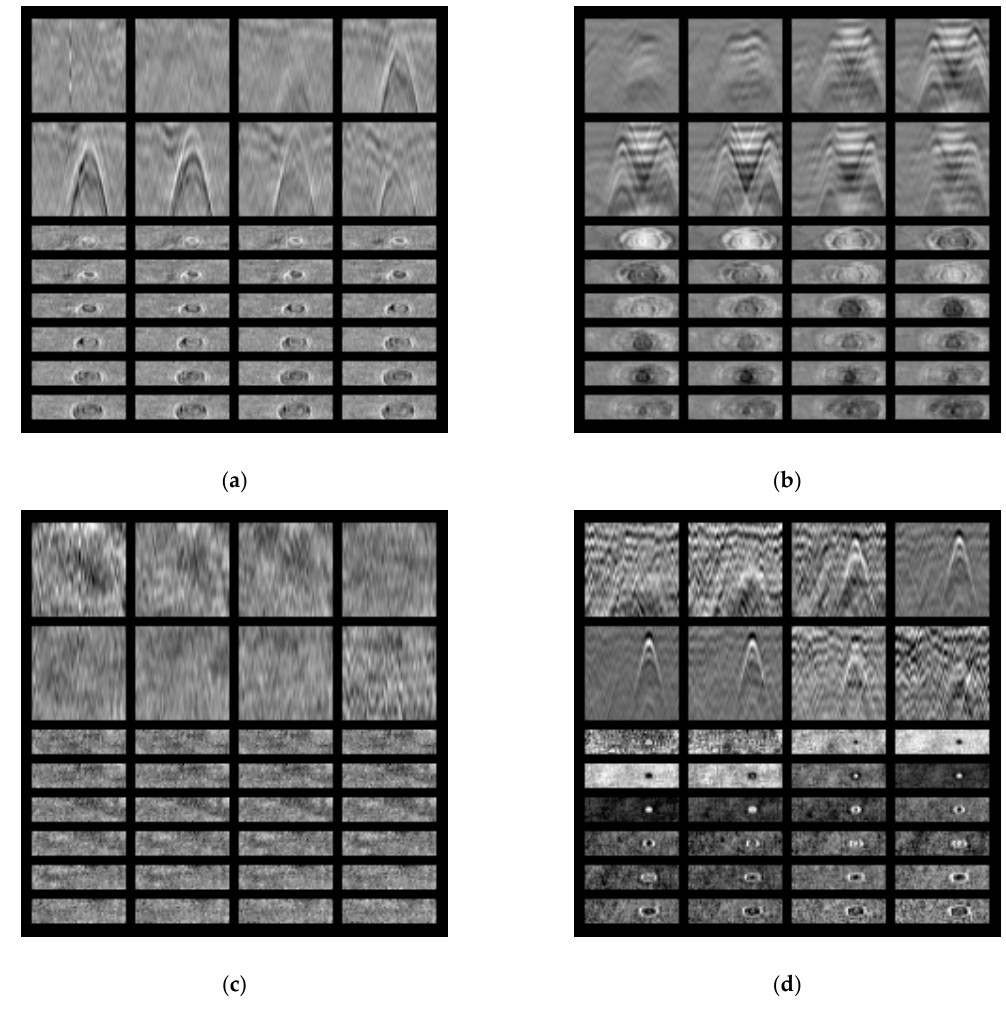
Figure 1. Representative 2D ground penetrating radar (GPR) grid images reconstructed from 3D GPR data: ( a ) cavity, ( b ) manhole, ( c ) subsoil background, and ( d ) gravel.